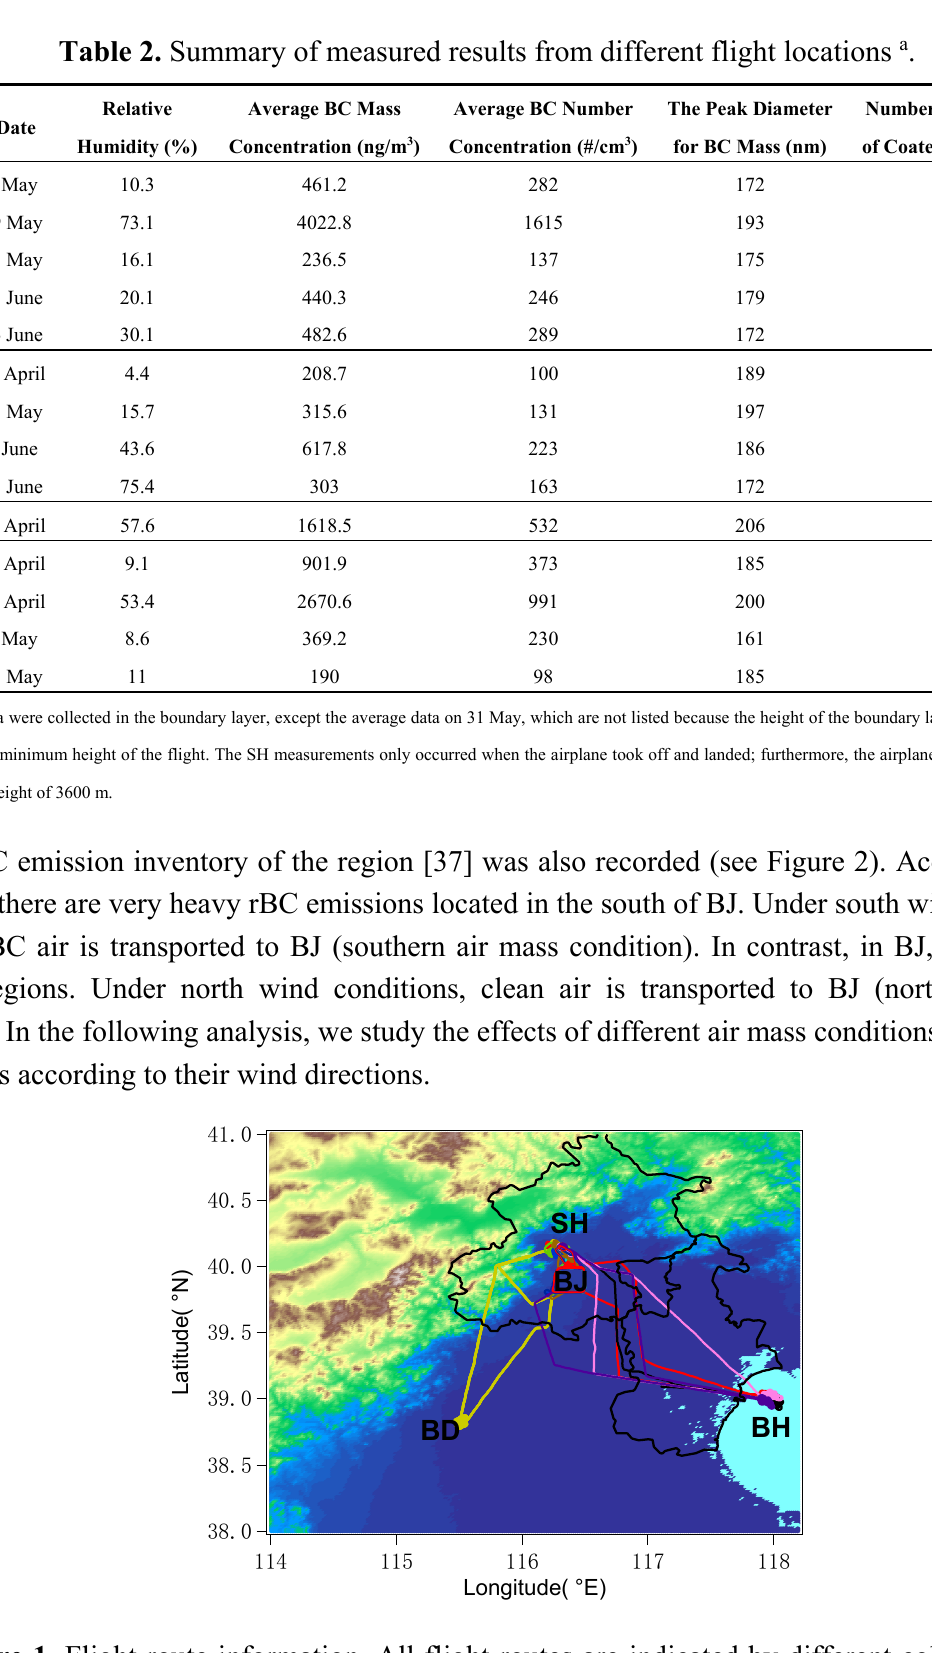
Figure 1. Flight route information. All flight routes are indicated by different color lines, and the labels (Beijing (BJ), Shahe (SH), Baoding (BD), and Bohai Sea (BH)) represent different locations where the vertical profiles of rBC were measured. The terrain of the region is shown by the shaded